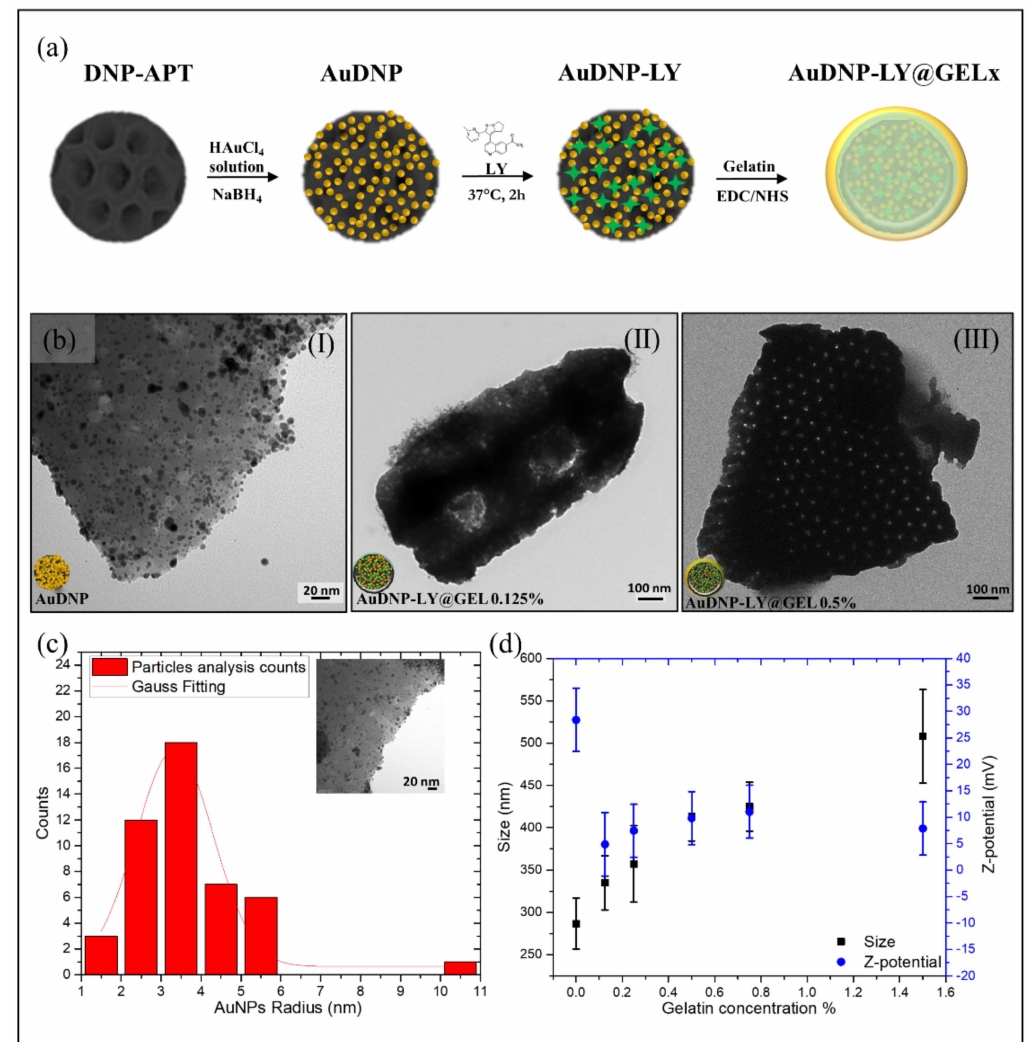
Figure 1. Preparation and Characterization of the AuDNP-LY@Gel system. ( a ) Schematic representation of the function- alization procedure. The growth of AuNPs on the surface of the DNP is achieved by dispersing amino-modified DNPs in the HAuCl 4 solution and adding gelatin as a stabilizing agent. NaBH 4 is used as the reducing agent. Then, the small molecule Galunisertib is loaded into the system and the gelatin shell is performed by crosslinking of the polymer matrix. The scheme is not in scale and not intended to represent the full sample composition. ( b ) TEM investigations of the AuDNP (I), AuDNP-LY@Gel 0.125% (II) and AuDNP-LY@Gel 0.5% samples ( c ). Particle size analysis of AuNPs decorating the surface of the DNP fitted by a Gaussian curve. ( d ) Change in the size (black) and surface charge (blue) of the samples AuDNP-LY@Gel according to the different gelatin amounts in the outer shell. The vertical bars are representative of the standard deviation (SD) on a minimum of three independent